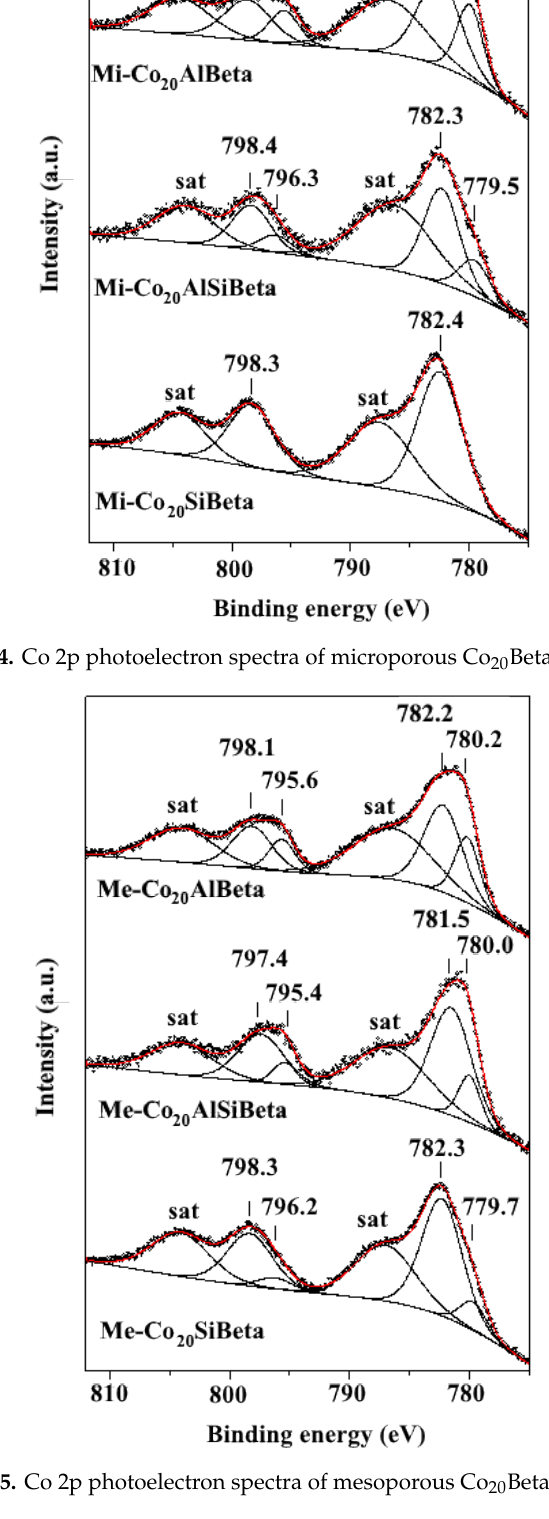
Figure 5. Co 2p photoelectron spectra of mesoporous Co 20 Beta zeolites.